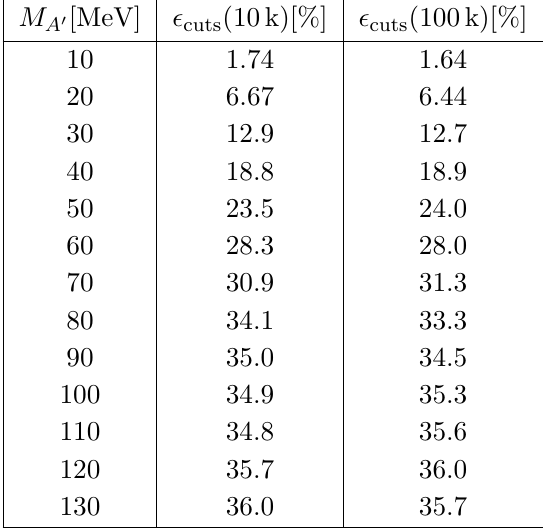
M [MeV] (cid:15) (10 k)[%] cuts A 0